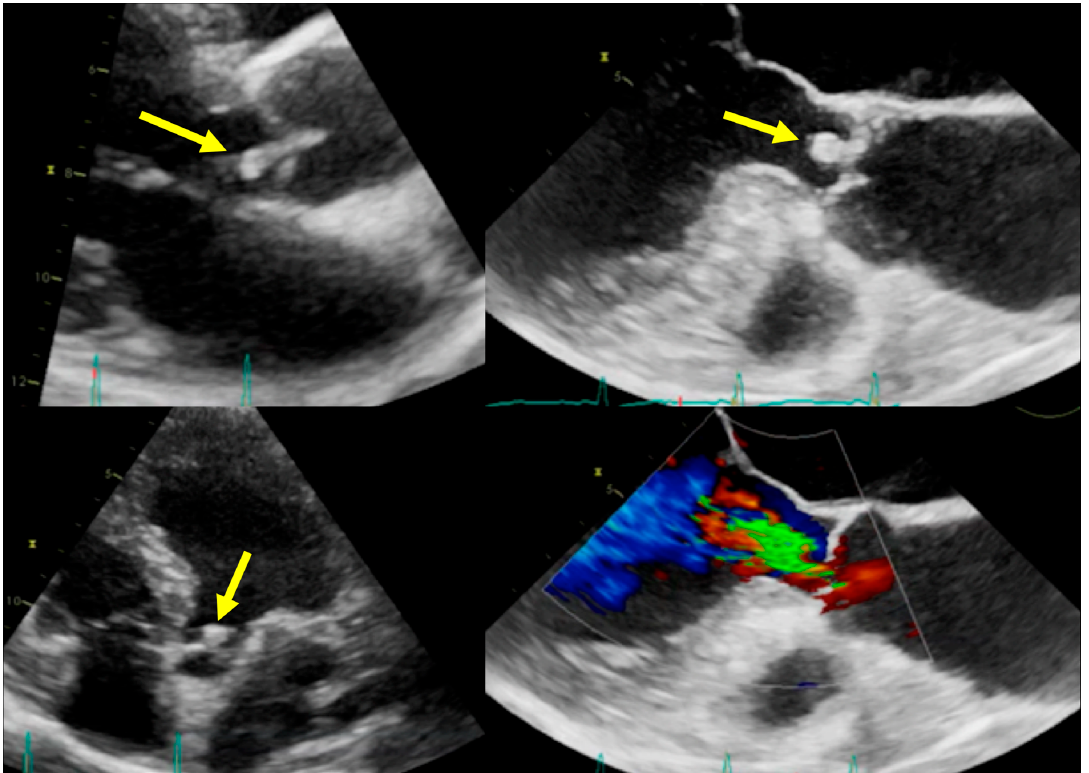
Figure 1. Infective endocarditis (IE) on aortic valve. Top and bottom left: Parasternal long axis and apical four-chamber transthoracic echocardiography (TTE) showing vegetation (arrows) in the left ventricle outflow tract. Top and bottom right: Transoesophageal echocardiography (TOE) showing the vegetation and the related valvular regurgitation.